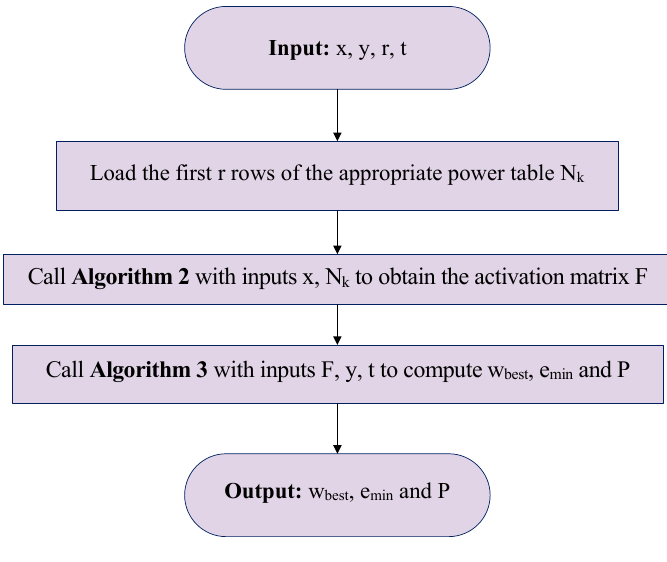
Figure 2. Flowchart for the training process of the FCI-WASD: The WASD